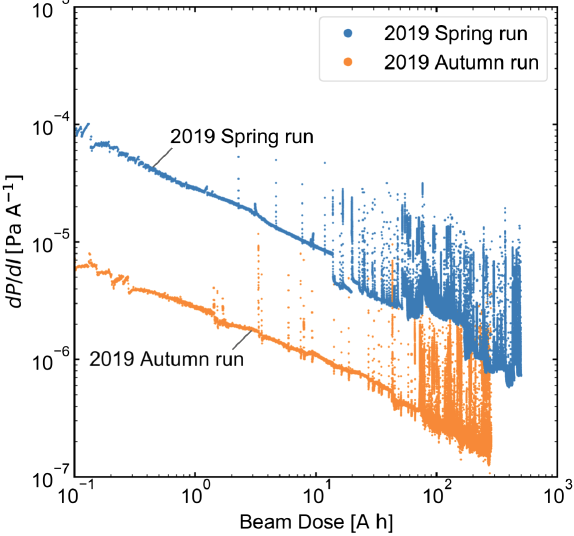
FIG. 10. Pressure-normalized beam current ( dP=dI ) as a function of the beam dose, measured with CCG beside the D02H1